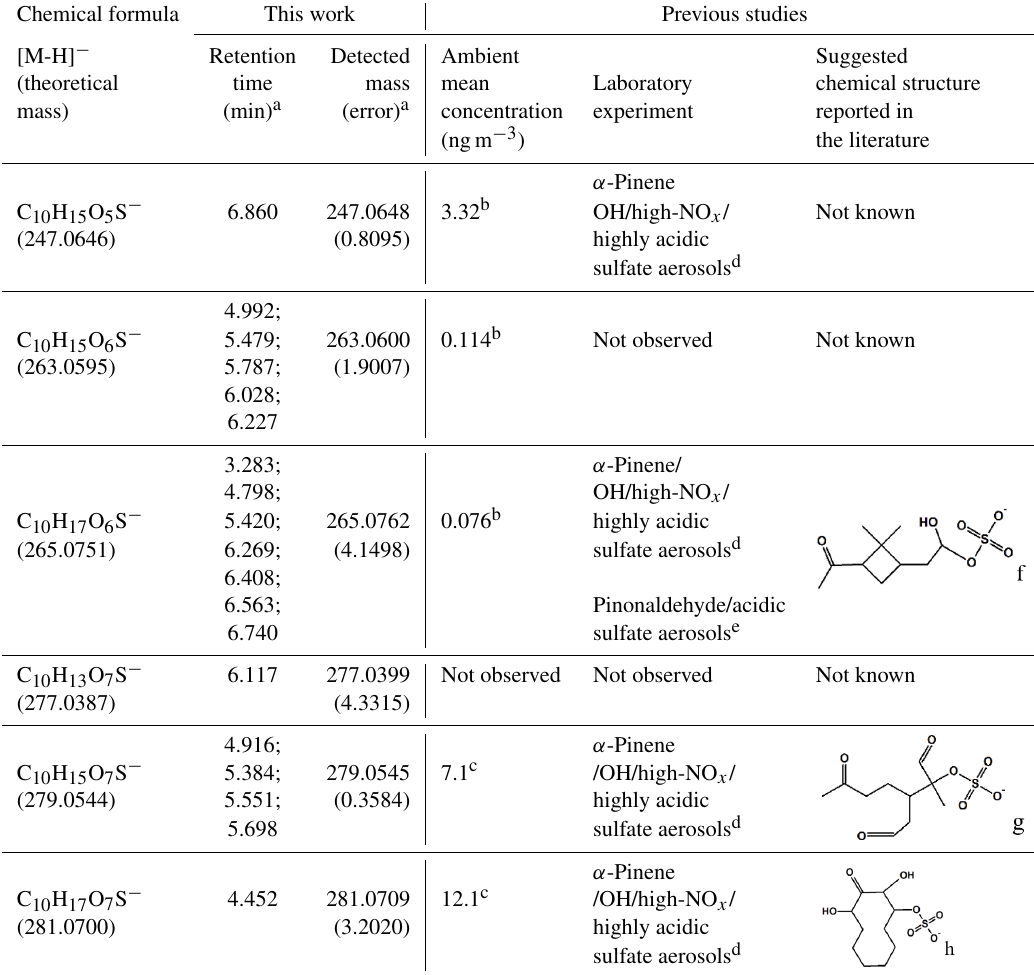
Table 2. Comparison of reaction products formed upon heterogeneous OH oxidation of α pOS-249 with the laboratory and field studies. Chemical formula This work Previous studies Retention Detected Ambient Suggested Laboratory chemical structure experiment reported in the